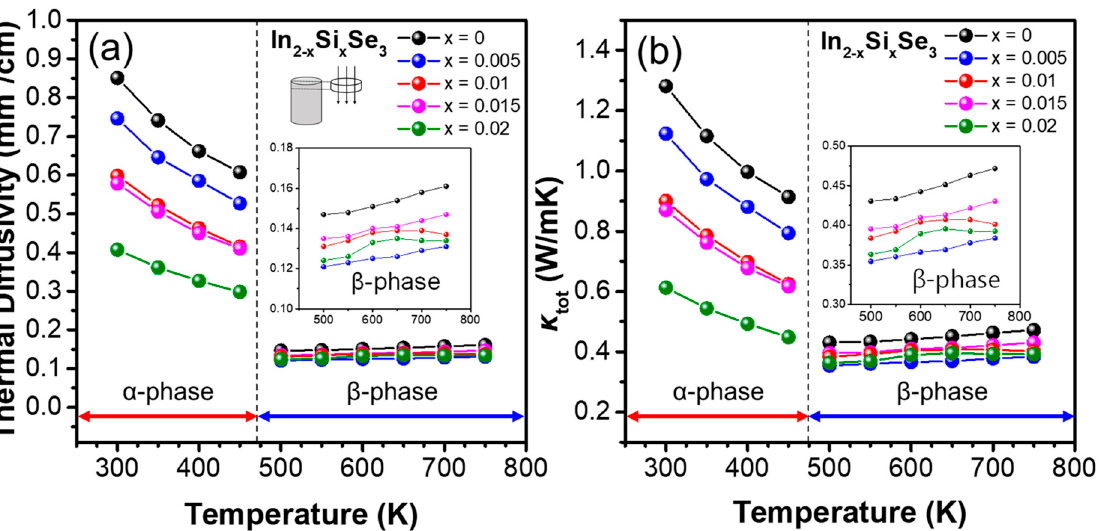
Figure 4. ( a ) Thermal diffusivities and ( b ) calculated total thermal conductivities as a function of temperature for the In 2 − x Si x Se 3 ( x = 0, 0.005, 0.01, 0.015, and 0.02) samples. temperature for the In 2 − x Si x Se 3 ( x = 0, 0.005, 0.01, 0.015, and 0.02)